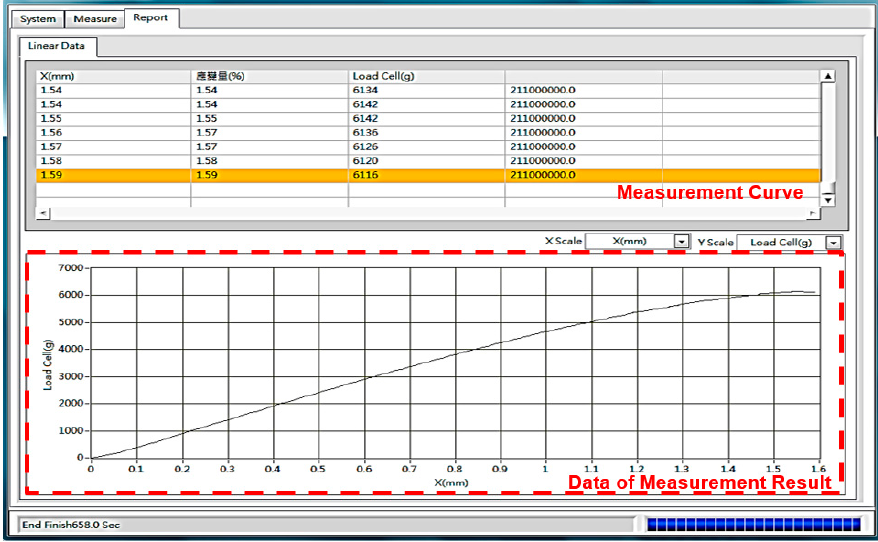
Figure 7. Measured results shown in the platform system interface.